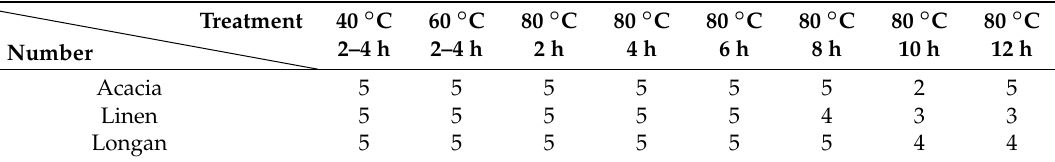
Table 2. Sample settings for the original honey